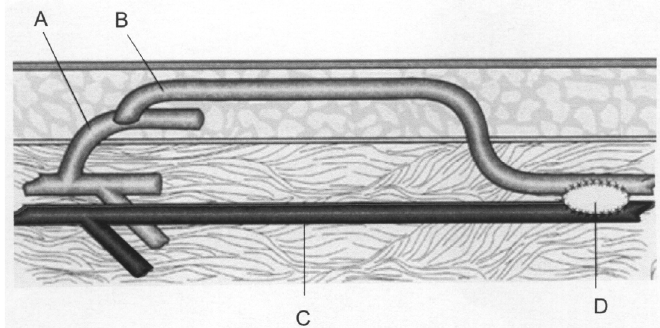
FIGURE 2 - Superficial femoral vein extension. A. Greater saphenous vein. B. SFV in the subcutaneous layer. C. Femoral artery. D. Femoral artery –